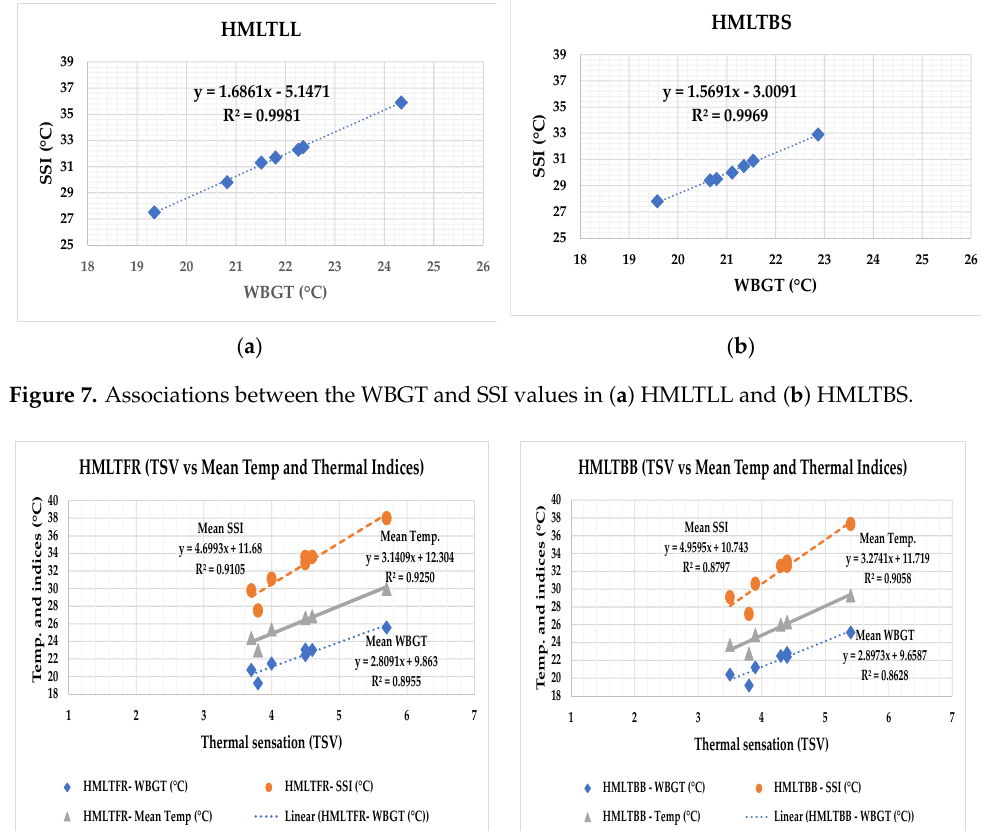
Energies 2021 , 14 , x FOR PEER REVIEW Figure 6. Associations between the WBGT and SSI values in ( a ) HMLTFR and ( b ) HMLTBB.